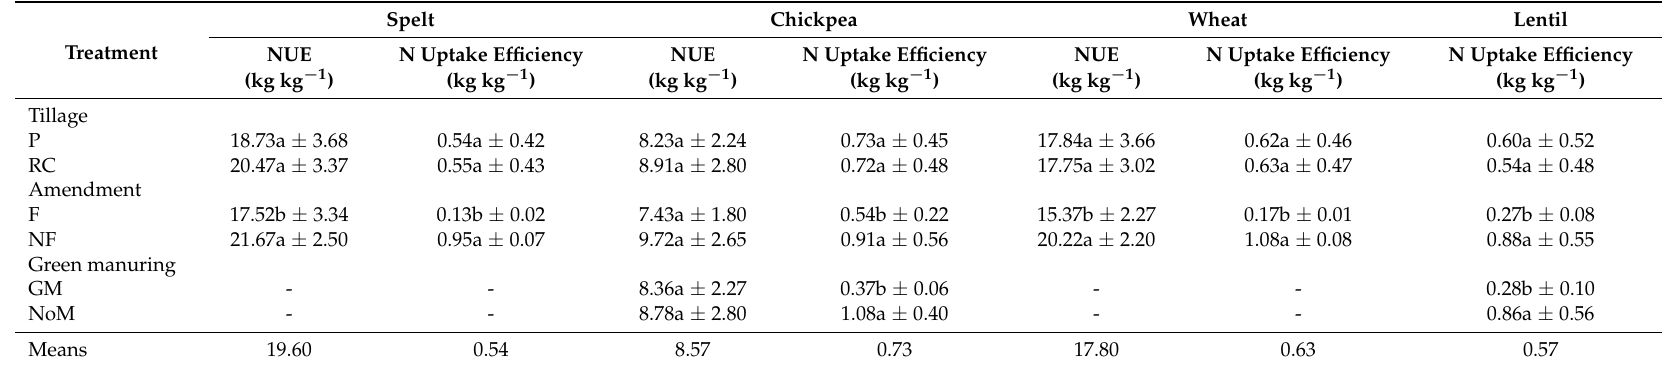
Table 4. Cash crops’ N efficiency parameters. Means ( ± Std Dev) are presented under different tillage systems, green manuring, and organic amendment strategies (P: conventional plough; RC: reduced chisel; F: composted farmyard manure; NF: unfertilized control; GM: green manure; NoM: no green manure). Spelt Chickpea Wheat Lentil Treatment